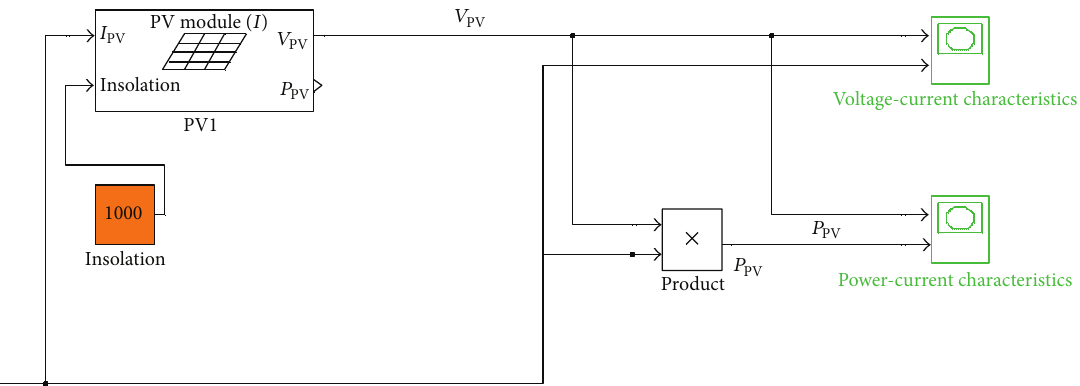
Figure 2: MATLAB model for PV module.